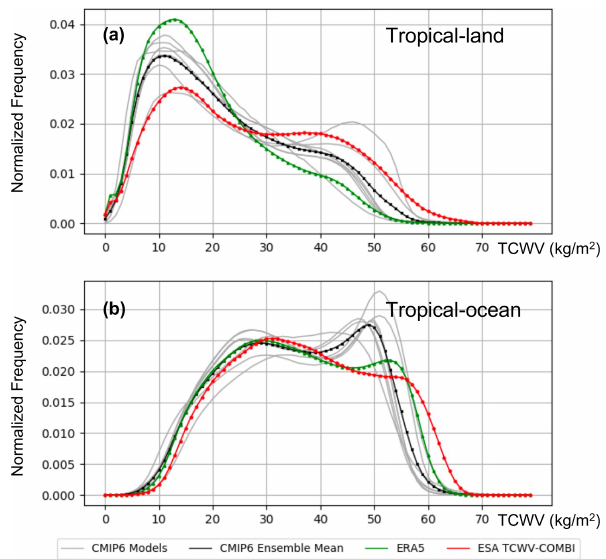
Figure 4. The normalized PDFs of the TCWV in the tropical area (30 ◦ S–30 ◦ N) over (a) land areas (under clear-sky-only conditions) and over (b) ocean areas (under all-weather conditions except for heavy precipitation). The grey lines denote the individual CMIP6 models, while the black line represents their ensemble mean. The green line represents ERA5, and the red line is the ESA CCI +